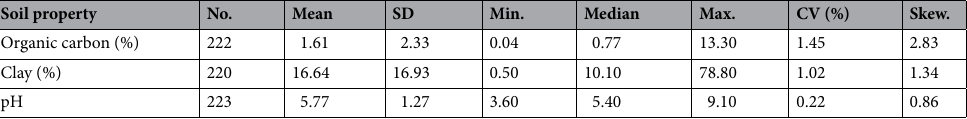
Table 1. Descriptive statistical summary of the soil properties. SD is the standard deviation, CV the coefficient of variation and Skew. is the skewness coefficient.